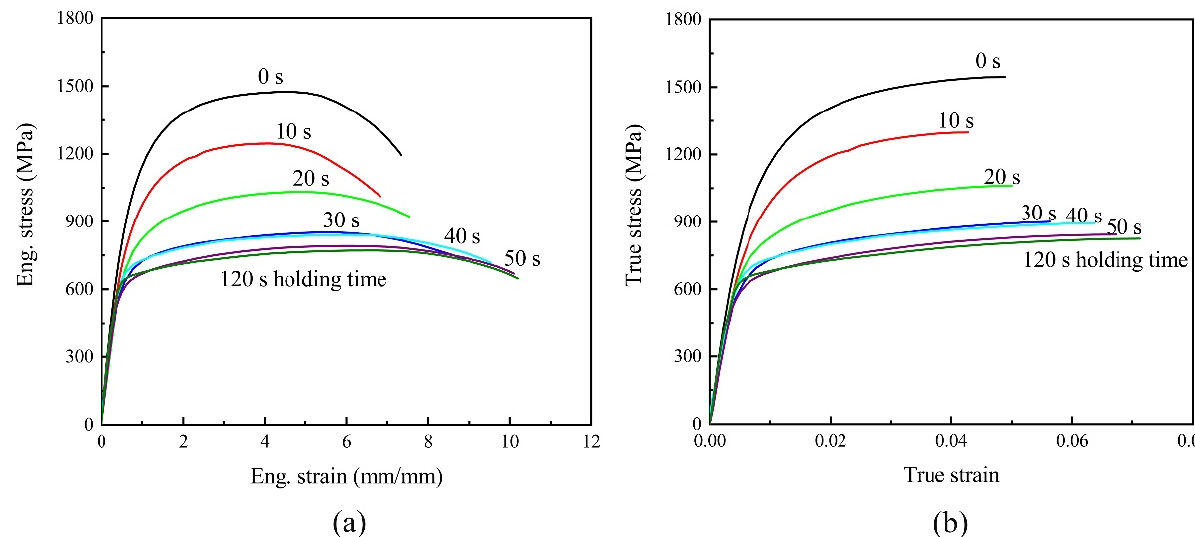
Figure 4. Flow curves of dogbone tensile specimens with different holding times: ( a ) engineering stress–strain curves; ( b ) true stress–strain curves.